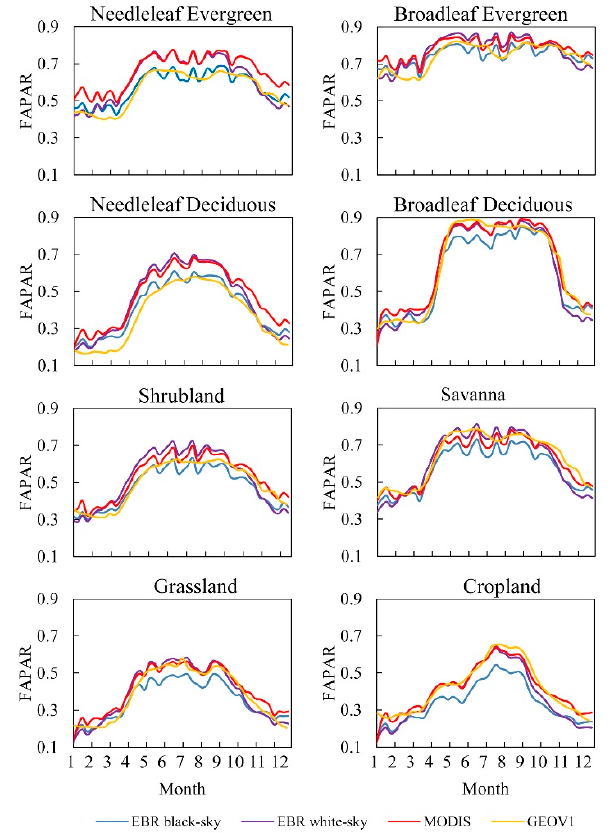
Figure 13. Time-series of the mean of the EBR black-sky, EBR white sky, MCD15A2H, and GEOV1 FAPARs of different vegetation types within tile H10V05 (located in North America, covering 30.0°N– 40.0°N and 80.0°W–104.4°W) for